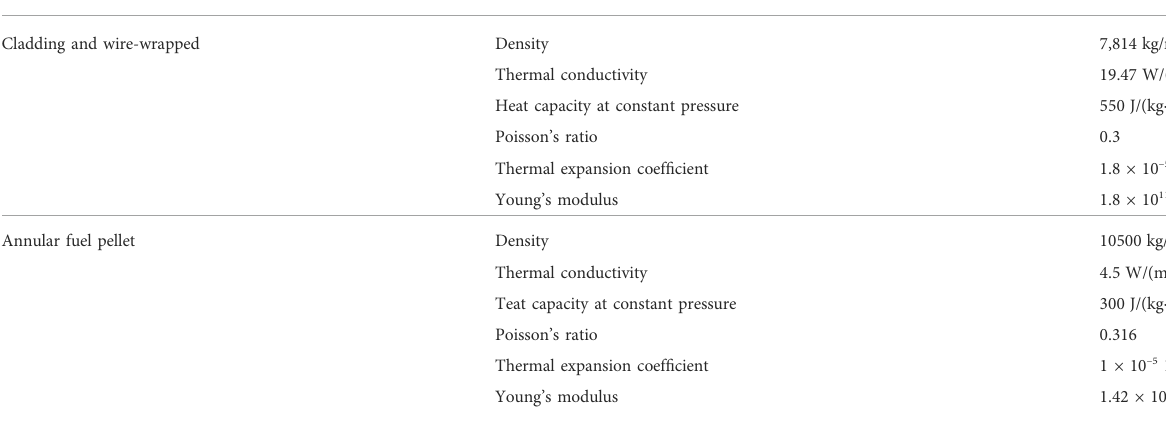
TABLE 5 The physical parameters of the solid